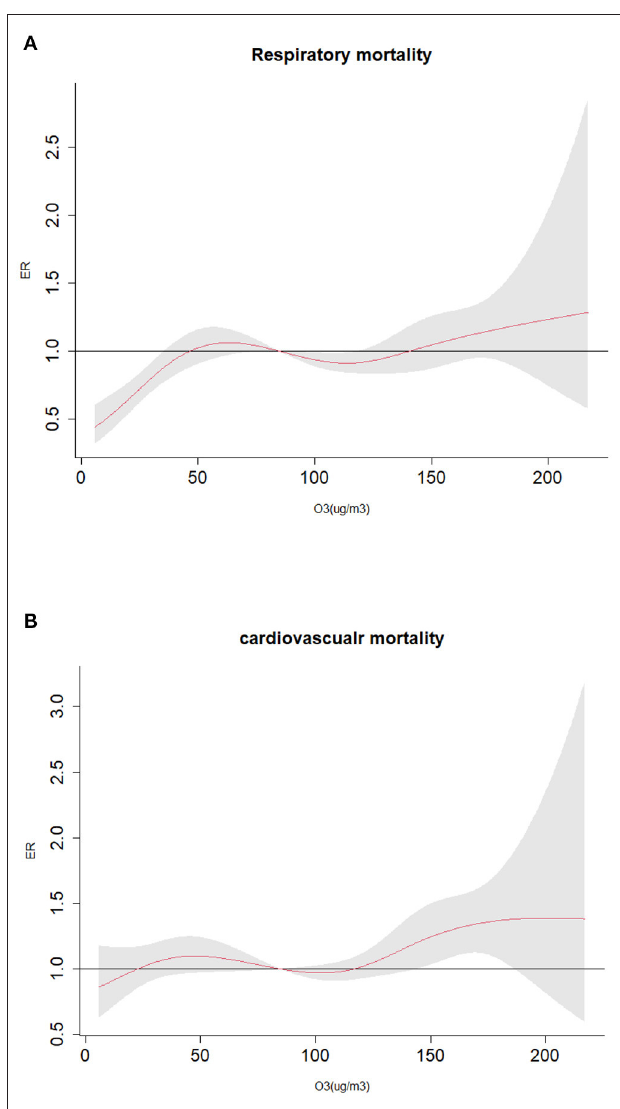
FIGURE 3 | Exposure-response curve of O 3 -8h to major death causes of residents; (A) O 3 -8h lead to respiratory mortality; (B) O 3 -8h lead to cardiovascular